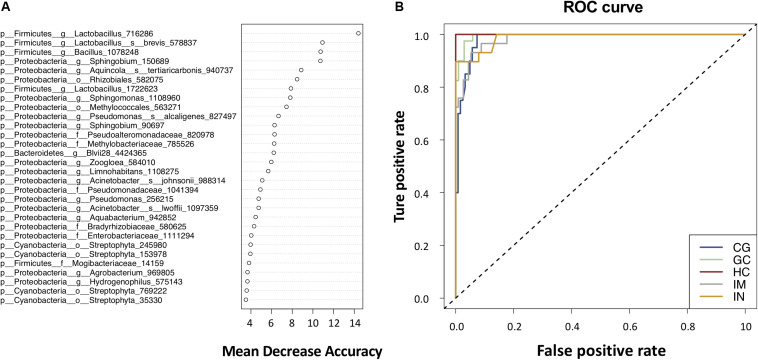
Gastric bacterial biomarkers for classifying histological types. (A) The random forest classifier identified 30 bacterial taxa that are most discriminatory among the disease stages in descending order. Each OTU was assigned an importance score (mean decrease accuracy). (B) ROC curves analysis to evaluate the discriminatory potential of gastric bacteria in identifying different.